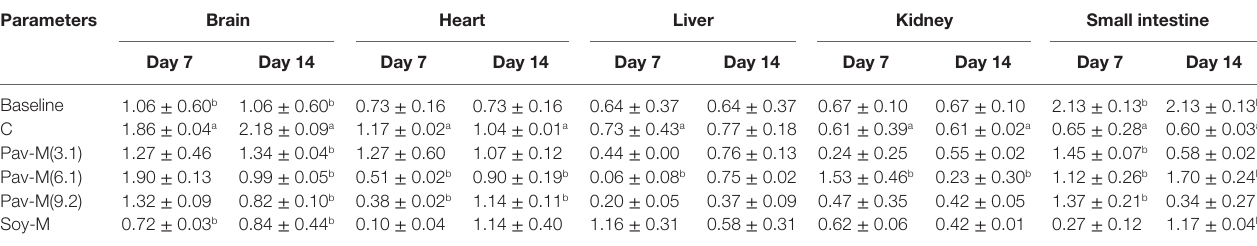
Value = mean ± SD (n = 3). Data within each column with different superscript alphabets are statistically different (P < 0.05). C, control; Pav-M(3.1), group with daily administration of 3.1 µl/g animal wt. pro-milk extract from A. pavonina seed; Pav-M(6.1), group with daily administration of 6.1 µl/g animal wt. pro-milk extract from A. pavonina seed; Pav-M(9.2), group with daily administration of 9.2 µl/g animal wt. pro-milk extract from A. pavonina seed; Soy-M, group with daily administration of 6.1 µl/g animal wt. pro-milk extract from soy bean seed. 7 or 14 is added before each abbreviation within text to indicate the days of administration.